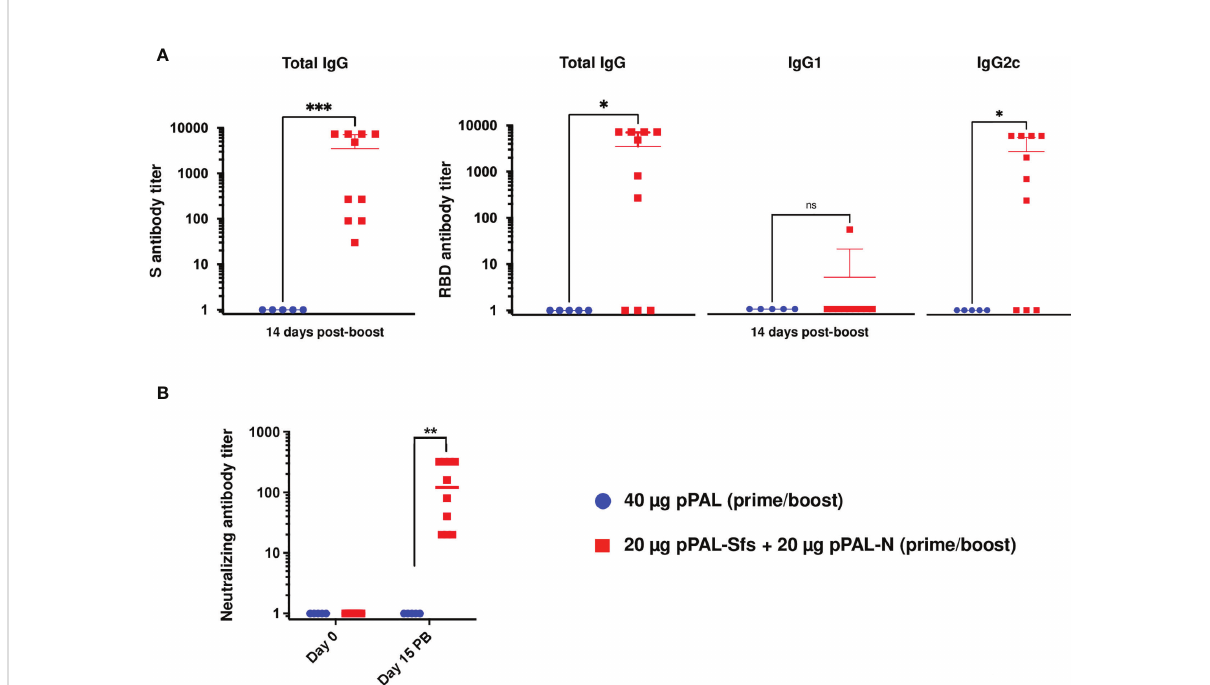
FIGURE 2 The pPAL-Sfs + pPAL-N vaccine candidates activate SARS-CoV-2 S- and RBD-speci fi c humoral immunity in C57BL/6J mice. The serum samples were collected 15 days after the booster dose. (A) ELISA determinations of individual and average titers of total circulating anti-S and anti-RBD IgG determined by ELISA using HRP-conjugated protein (A) ELISA determinations of individual and average titers of circulating anti-RBD IgG, IgG1, and IgG2c using HRP-conjugated goat anti-mouse IgG1, anti-IgG2, and anti-IgG2c. The average anti-S and anti-RBD IgG titers are ≥ 2,000. The IgG2c/IgG1 ratio is ~750 in vaccinated animals with respect to the pPAL control group. (B) The neutralizing antibody titer average is >100. Statistical inference was performed using the Student ’ s t-test applying p-value adjustment by the Holm-Sidak method ( a = 0.05; *p<0.05; **p<0.01; ***p<0.001; ns, non-signi fi